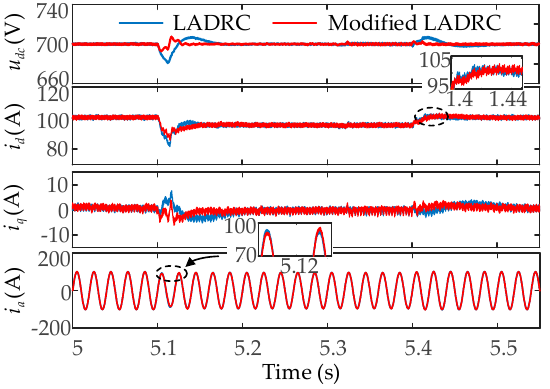
Figure 15. Robustness comparison under module temperature